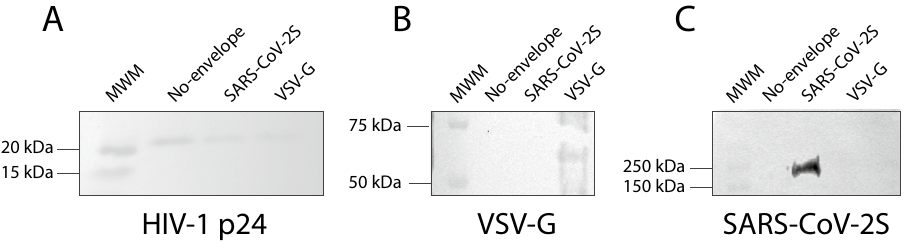
Figure 2. Western blot analysis of produced VP. ( A ) The structural protein p24 was detected on the 3 types of produced VP. ( B ) VSV-G was selectively detected on VSV-G VP but not on either SARS-CoV-2 S or no-envelope protein VP. ( C ) The S protein was detected as a 170 kDa protein on SARS-CoV-2 VP using a chimeric monoclonal antibody, but not on VSV-G VP. Detection of viral proteins was performed twice, of which one is shown. Original blots are presented in Sup. Fig. 2.